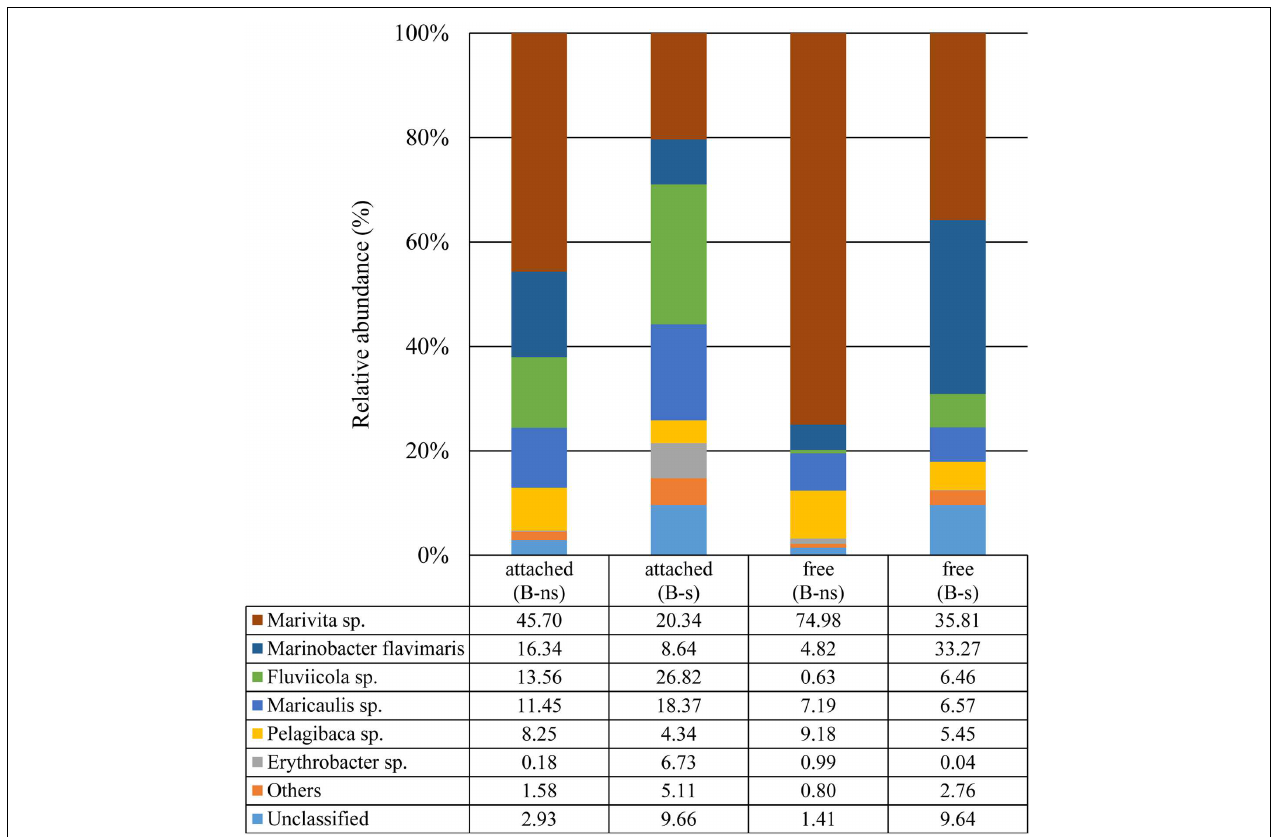
FIGURE 5 | Taxonomic classification of bacterial 16S rDNA (V3–V4) Illumina reads at species